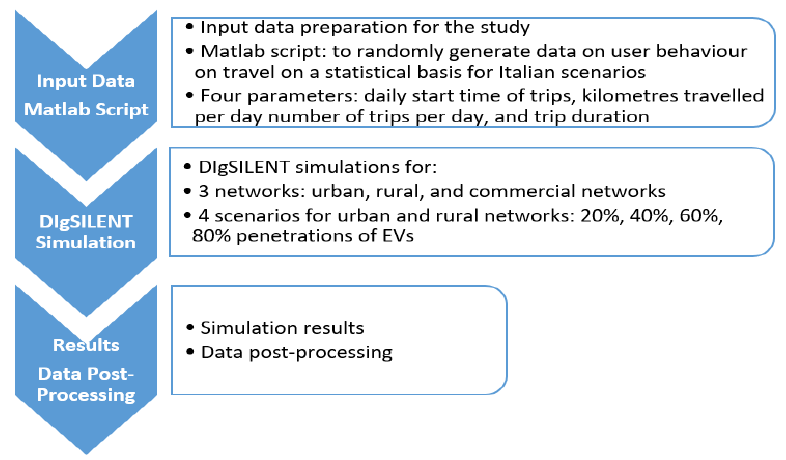
Figure 2. Simplified block diagram of the simulation procedure.